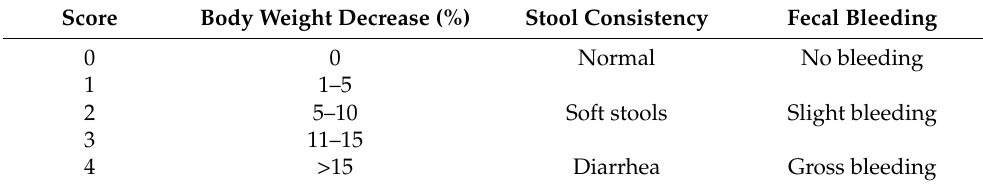
Table 1. Disease activity index (DAI)